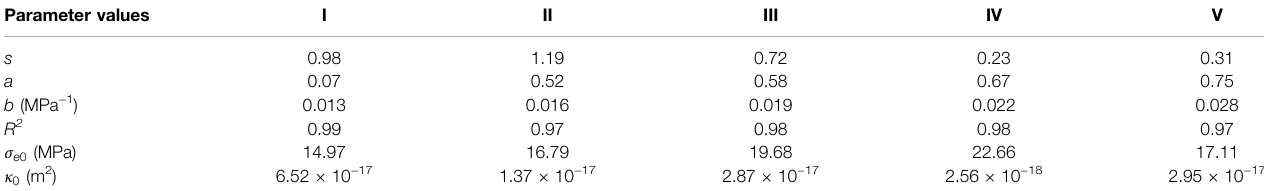
TABLE 2 | List of the values of σ e 0 and κ 0 used for each stage and parameter values obtained from the best fi tting of Eq. 2 to the permeability data shown in Figure 7 . Parameter values